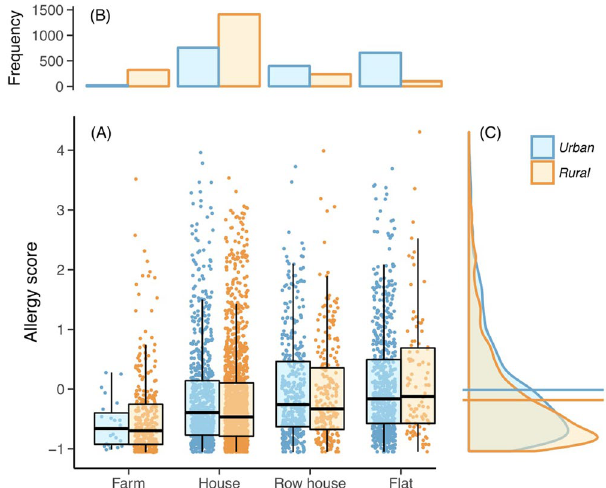
Figure 2. Housing type in relation to allergy score in allergy-tolerant breeds. ( A ) The type of living apartment was associated with the allergy score ( P < 0.0001, based on generalized least squares, assuming group-specific residual variance). While the pattern was repeated for both urban (blue) and rural (orange) environments (and overall the allergy score was higher in urban environments as shown in ( C ); P = 1.3e − 9 ), the type of the apartment was also related to the living environment—this is shown in panel ( B ) ( χ 2 = 901.4, P < 2.2e − 16 ), and thus the effect of these is hard to separate. ( B ) The frequency of different housing types across urban and rural environments. ( C ) The distribution of allergy score in urban and rural individuals, across all housing types. Horizontal lines indicate mean values for each distribution showing that the mean allergy score is higher in urban than in rural individuals. In Fig. 2B,C the redundant axes have been omitted.